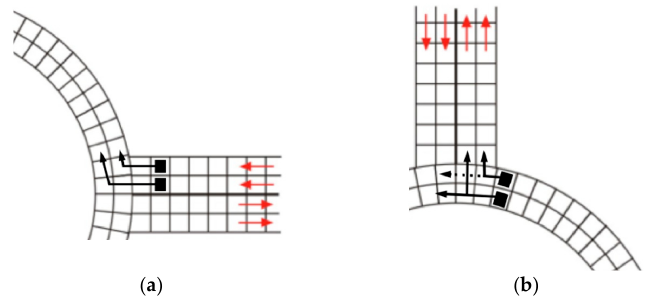
Figure 6. Scenario 5: possible directions of vehicle movement in the roundabout ( a ) enter; ( b ) exit.